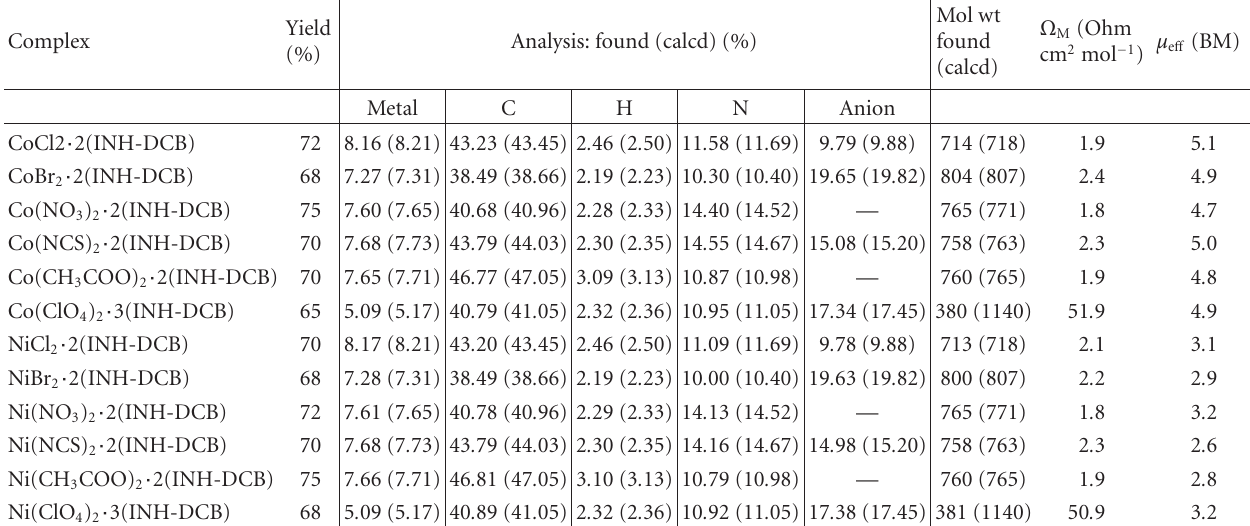
Table 1: Analytical conductivity, molecular weight, and magnetic data of Co 2+ and Ni 2+ complexes of INH-DCB.